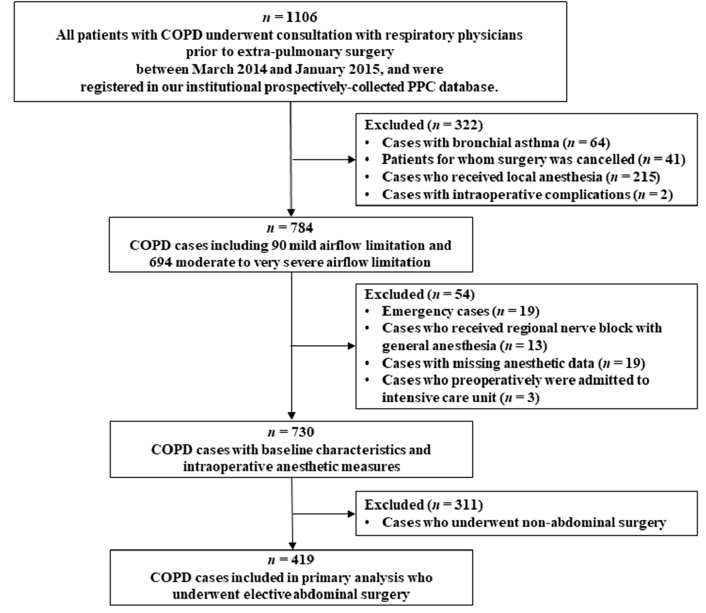
Figure 1. Consolidated standards of reporting trials diagram.